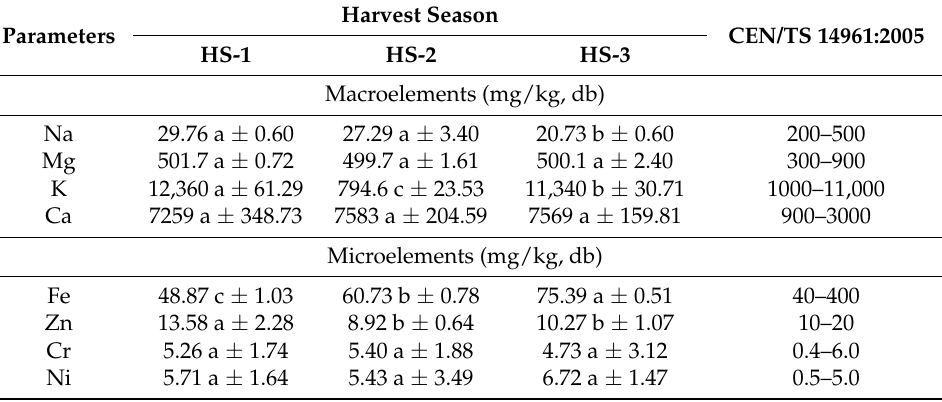
Table 5. Macro and micro elements of the investigated Sida hermaphrodita biomass and typical values for Miscanthus biomass